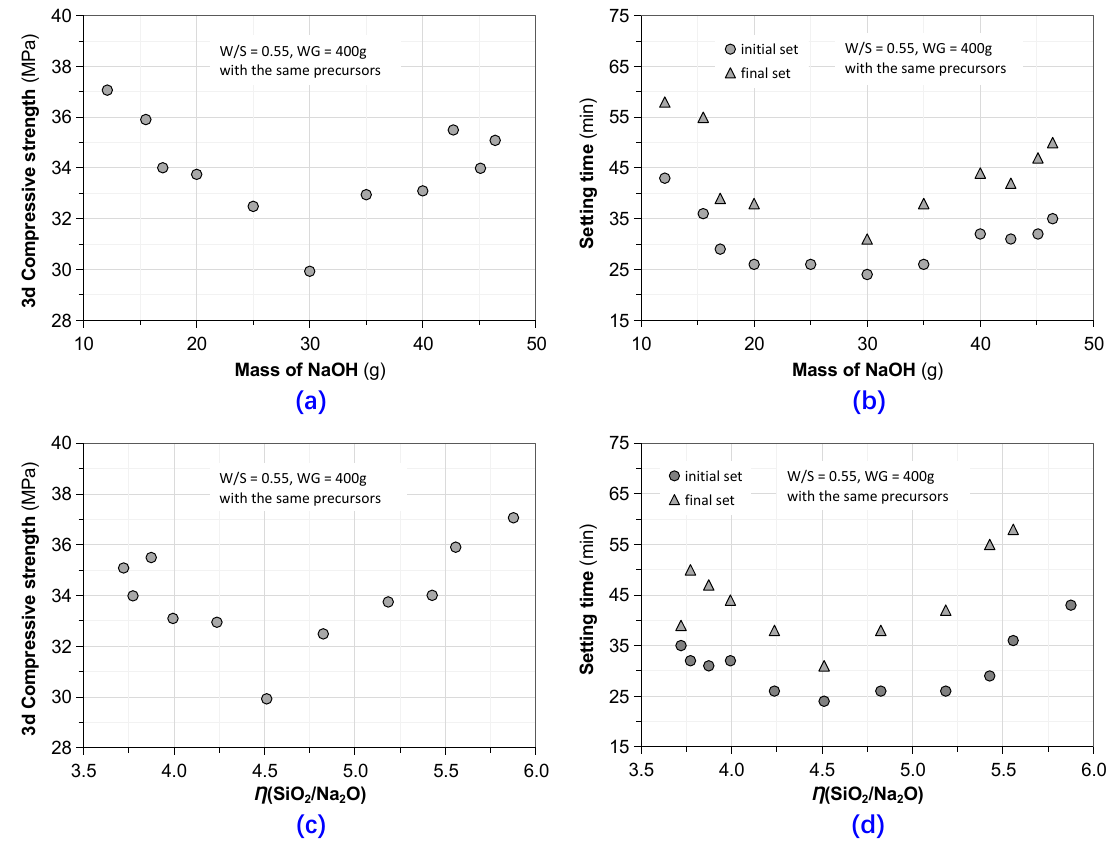
Figure 12. A critical observation on setting time and compressive strength: ( a , b ) compressive strength at the age of 3 days and setting time vs. the mass of NaOH; ( c , d ) compressive strength at the age of 3 days and setting time vs. η (SiO 2 / Na 2 O), respectively.